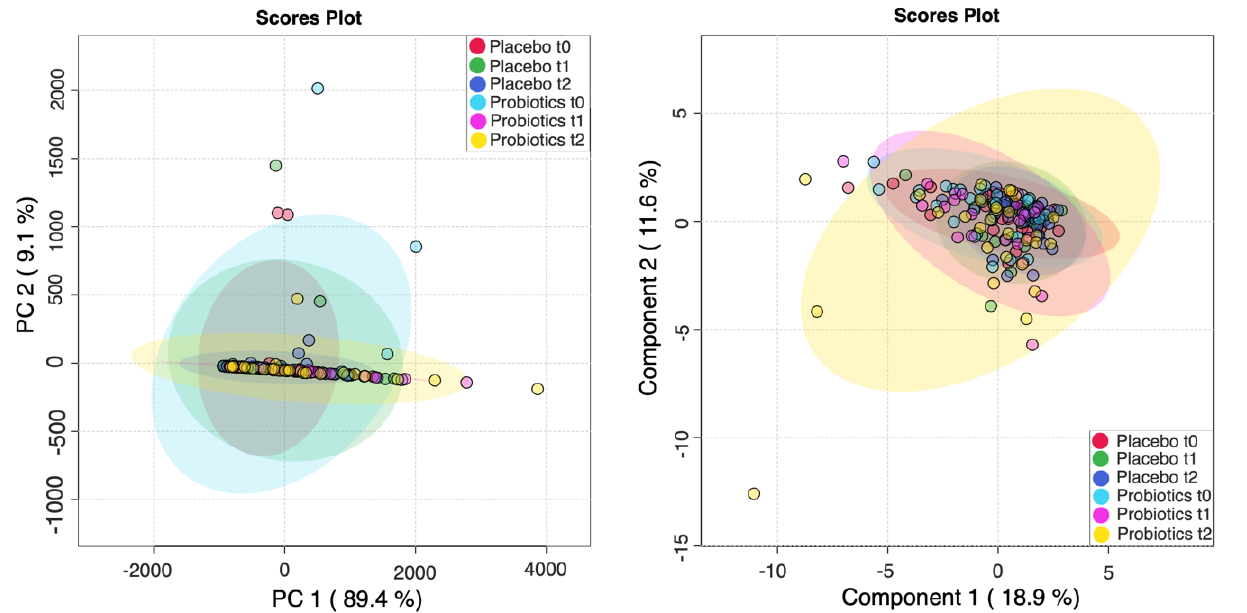
Figure 3. Untargeted metabolomics of the placebo ( n = 29) and intervention groups ( n = 28) in stool. ( A ) Principal component analysis (PCA), principal component (PC) 1 of 89.4% and PC2 of 9.1%. ( B ) Untargeted metabolomics of the placebo ( n = 29) and intervention group ( n = 28) in stool. Partial least-squares–discriminant analysis (sPLS-DA) Scores plot: Component 1 of 18.9% and Component 2 of 11.6%.